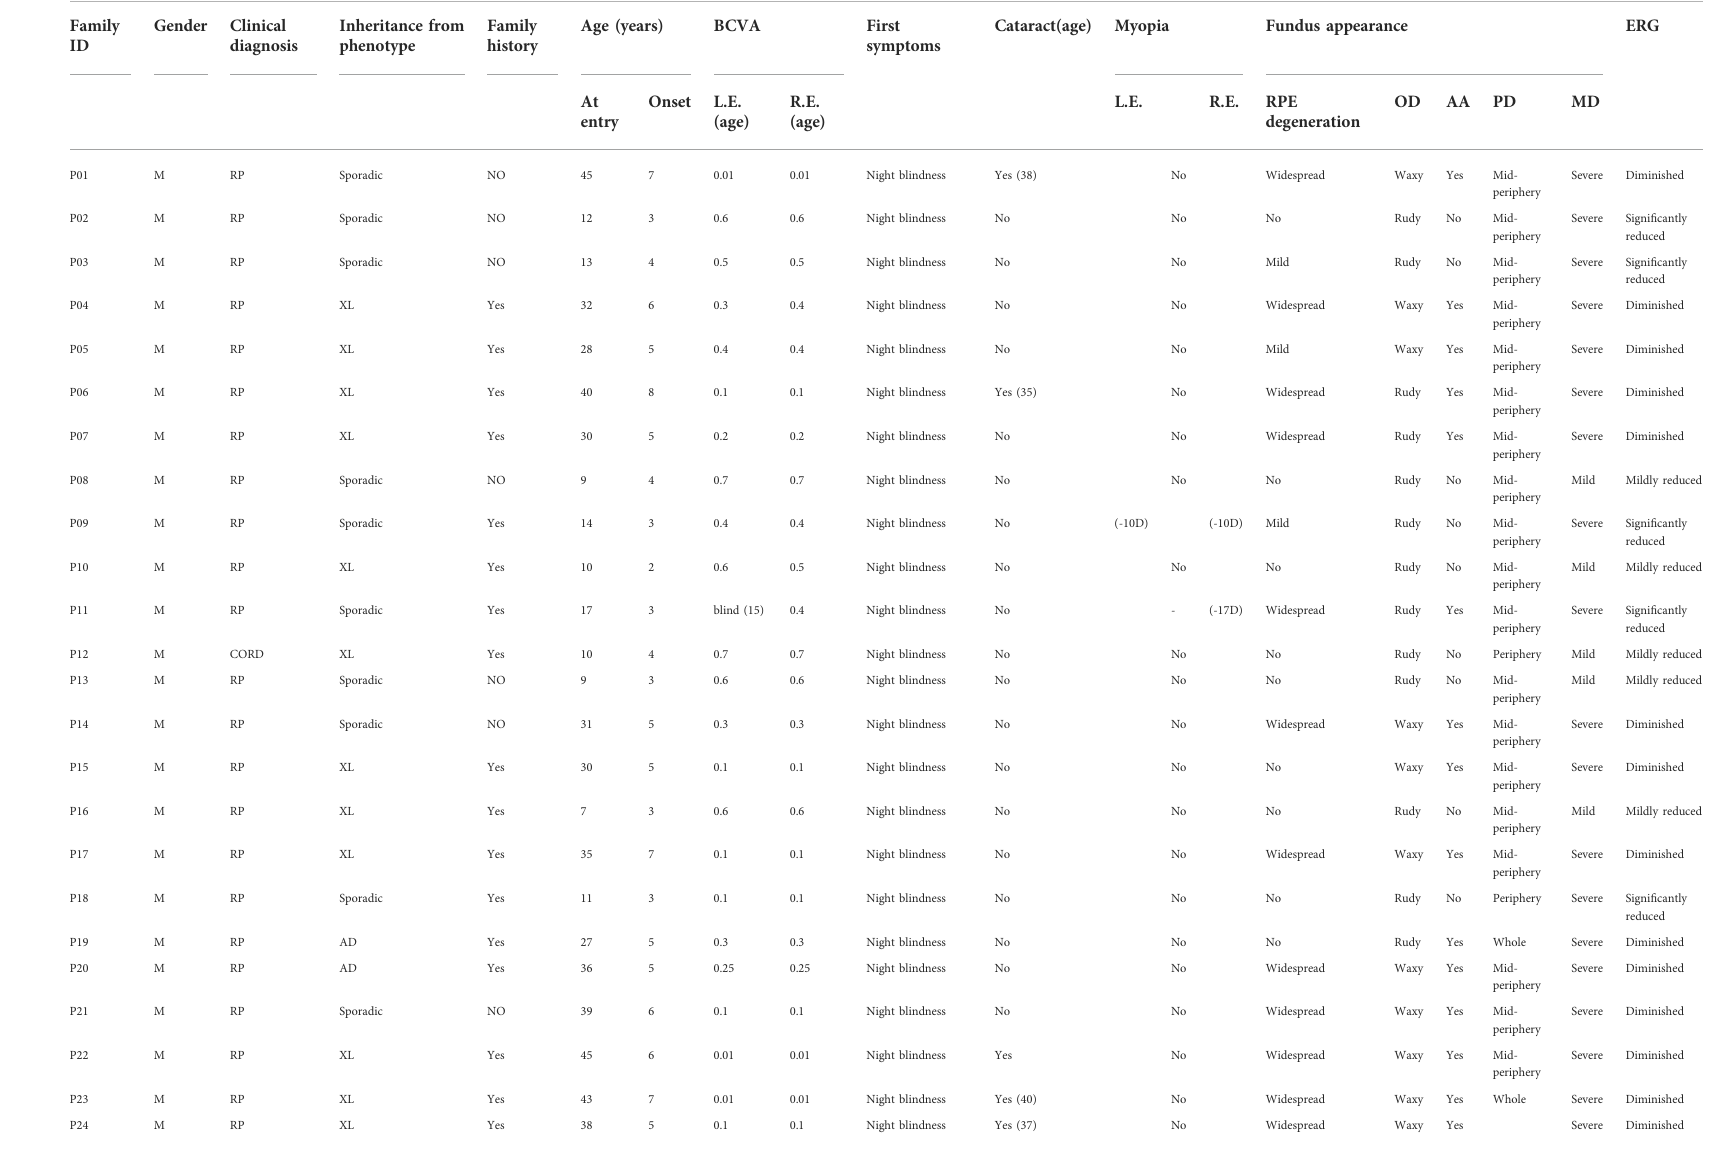
TABLE 1 Clinical information of 41 Chinese X-linked inherited retinal dystrophy families caused by RPGR mutations. Family